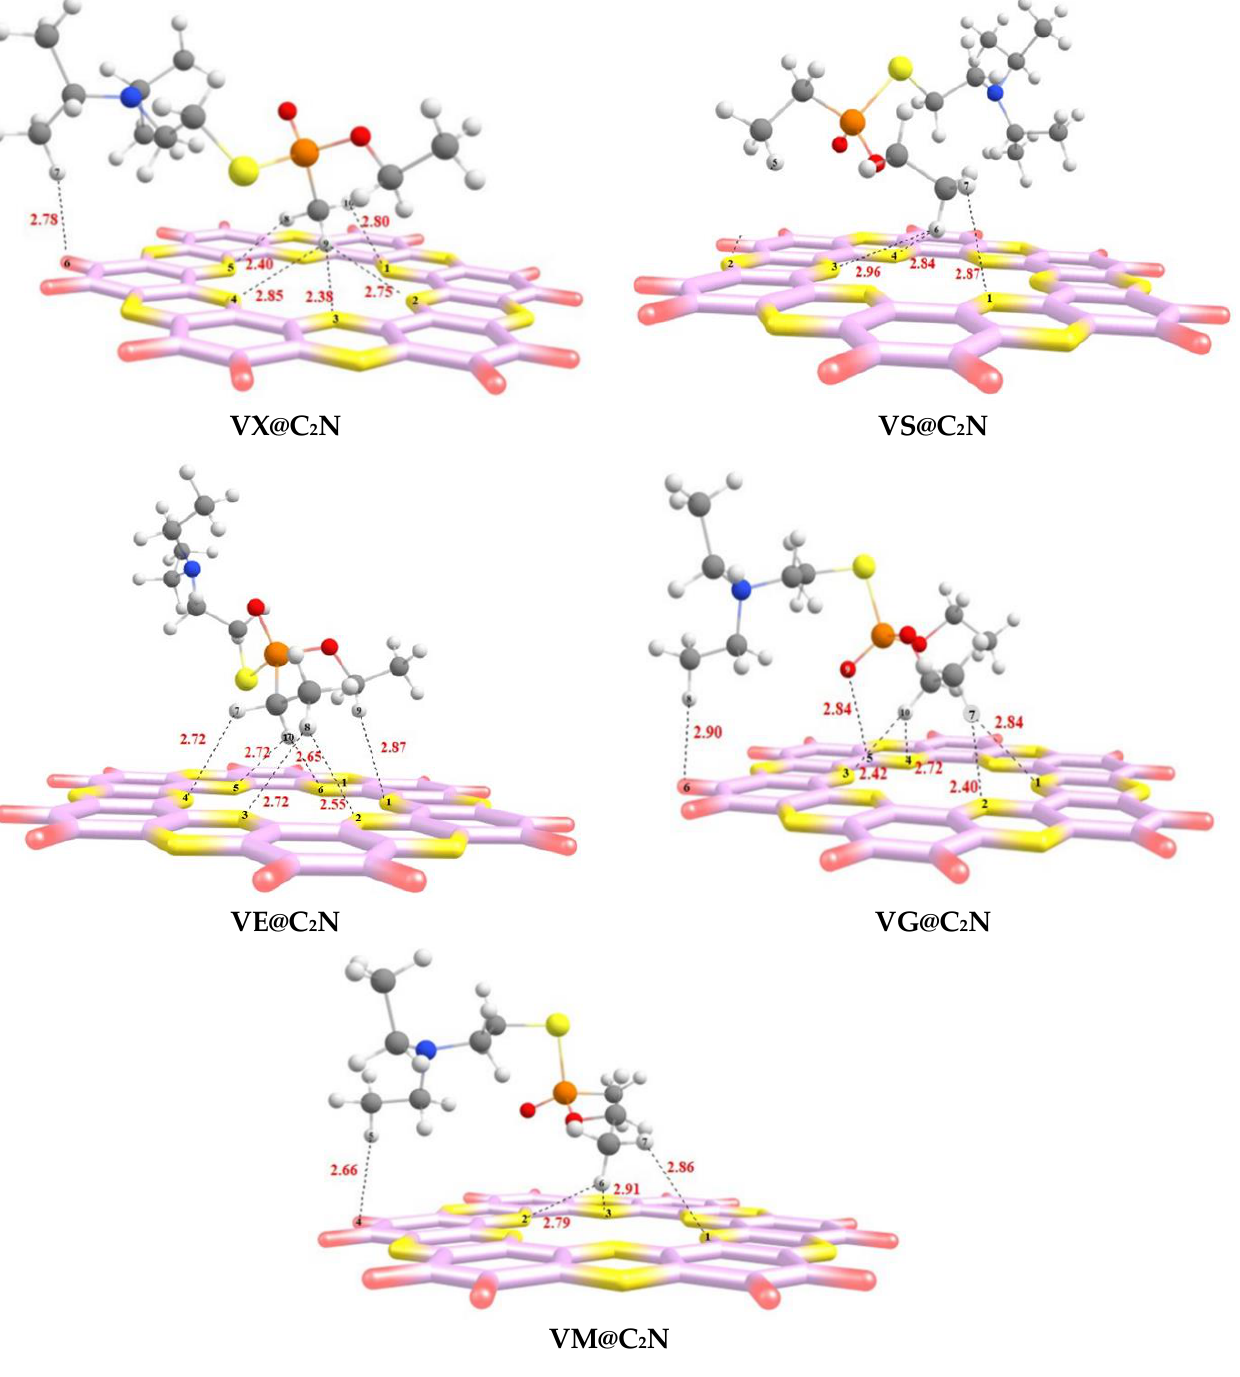
Figure 3 . The optimized geometries of V-series@C 2 N complexes at M05-2X/6-31++G(d,p) level of theory.